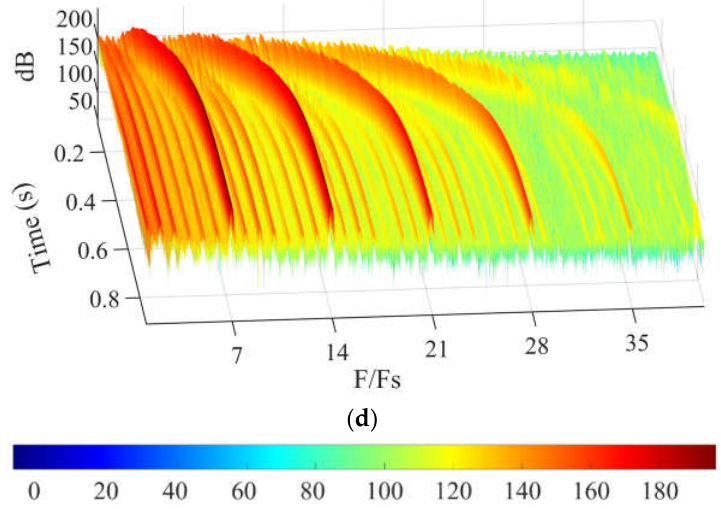
Figure 17. Time–frequency characteristics of pressure at the impeller: ( a ) bp2, ( b ) bp3, ( c ) bs2, and ( d ) bs3.